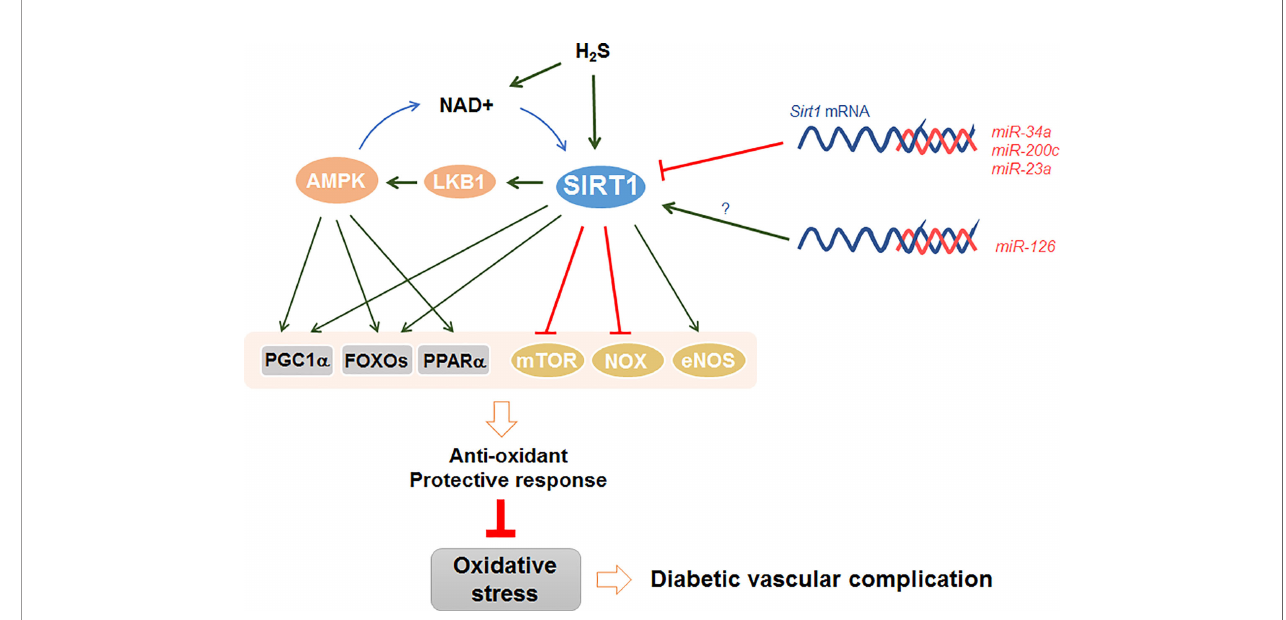
FIGURE 2 | SIRT1 antagonizes oxidative stress in diabetic vascular complications. SIRT1 directly or cooperatively with AMPK to activate various downstream effectors, including PGC1 a , FOXOs, and PPAR a . SIRT1 also stimulate eNOS and inhibit NOX and mTOR to trigger anti-oxidant protective response. In addition, H 2 S can either activate SIRT1 directly via sulfydration, or indirectly via increasing NAD+ level. Furthermore, several miRNAs, such as miR-34a, miR-200c, and miR-23a, directly inhibit the mRNA expression of sirt1 in DM, while other miRNAs including miR-126 promote sirt1 expression indirectly with unclear